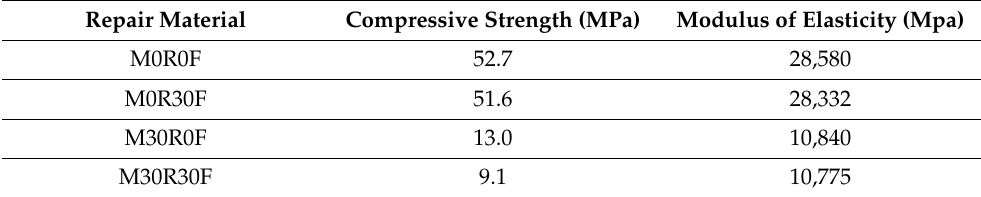
Table 5. Compressive strength and modulus of elasticity of various materials used for